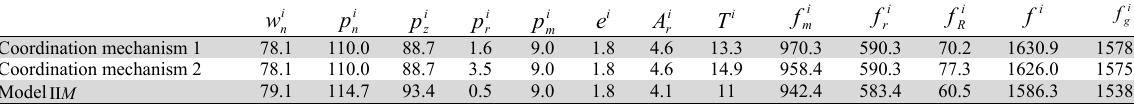
Optimal solutions under different coordination mechanisms